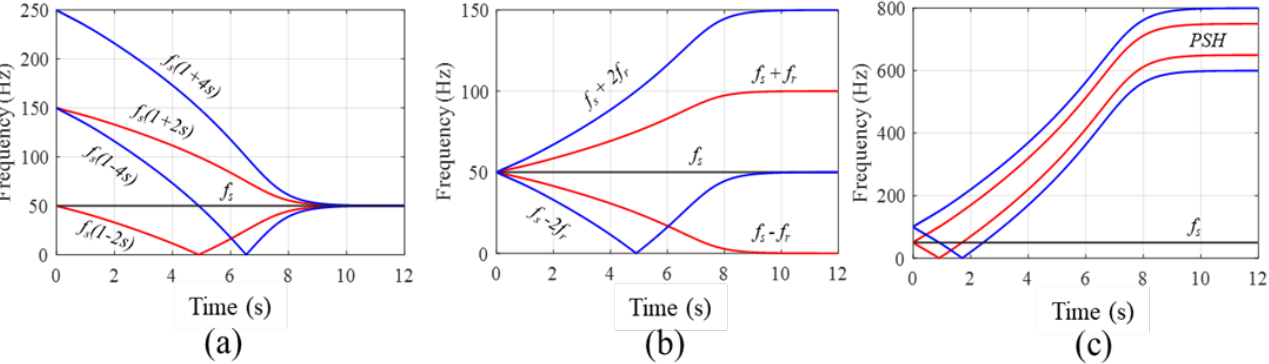
Figure 1. The development of frequency patterns in a transient regime due to ( a ) broken bars, ( b ) dynamic eccentricity and ( c ) principal slotting harmonics.